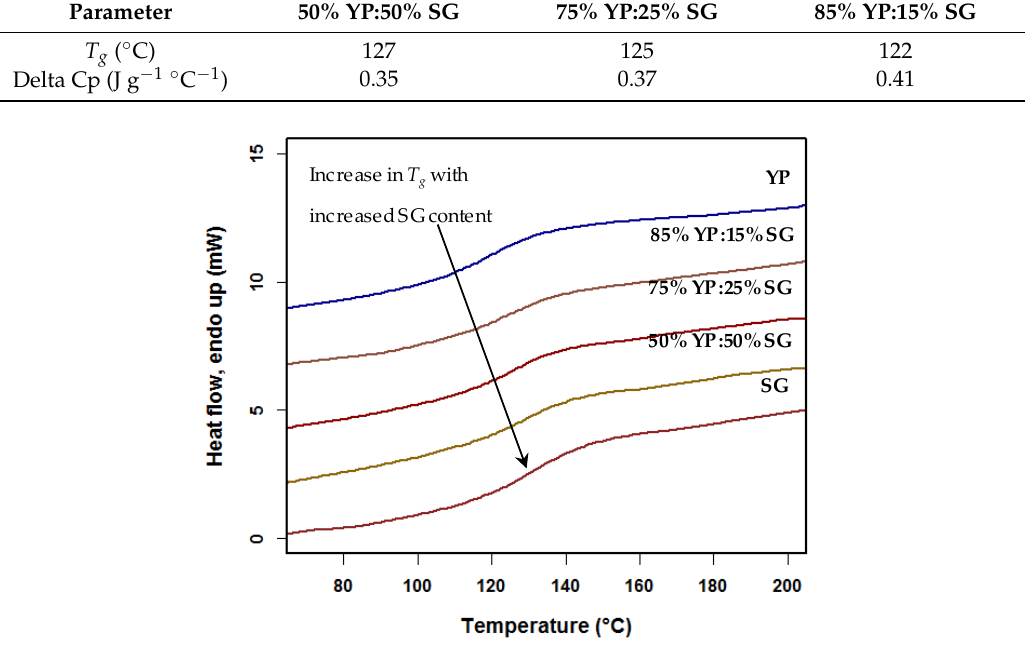
Figure 3. Differential scanning calorimeter (DSC) thermograms of switchgrass, yellow poplar, and vary ratios (YP:SG w/w ) lignin composition.